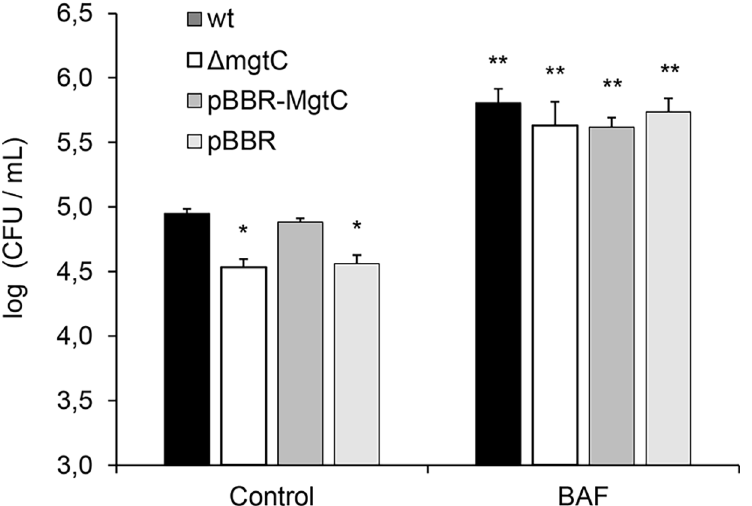
Fig 6. Treatment of THP-1 cells with bafilomycin A1 restores the intracellular survival defect of B . pertussismgtC deletion mutant strain to wild type B . pertussis levels. THP-1 macrophages were treated with 50 nM bafilomycin A1 (BAF) dissolved in DMSO or with DMSO alone (control condition) for 1 hour prior infection with either wild type B . pertussis (wt), B . pertussismgtC deficient mutant ( Δ mgtC ), B . pertussismgtC deficient mutant carrying the pBBR1MCS vector (pBBR), and B . pertussismgtC deficient mutant carrying a pBBR1MCS derivative that encodes mgtC (pBBR- mgtC ).After 2 h of infection cells were treated with polymyxin B and 48 hours after infection intracellular survival was assessed by lysing cells and enumerating CFUs. The means ± SD of triplicates of one representative experiment out of two performed are given. The survival of the Δ mgtC and pBBR strains in control conditions was significantly different from the survival of the wt and pBBR- mgtC strains in control conditions. Statistical significance analysis was performed using one-way ANOVA ( (cid:3) P < 0.05). The survival of wt, Δ mgtC ,pBBR, and pBBR- mgtC strains in BAF treated cells was significantly higher than the survival of any of these strains in untreated cells (control conditions). Statistical significance analysis was performed using one-way ANOVA ( (cid:3)(cid:3) P < 0.05).